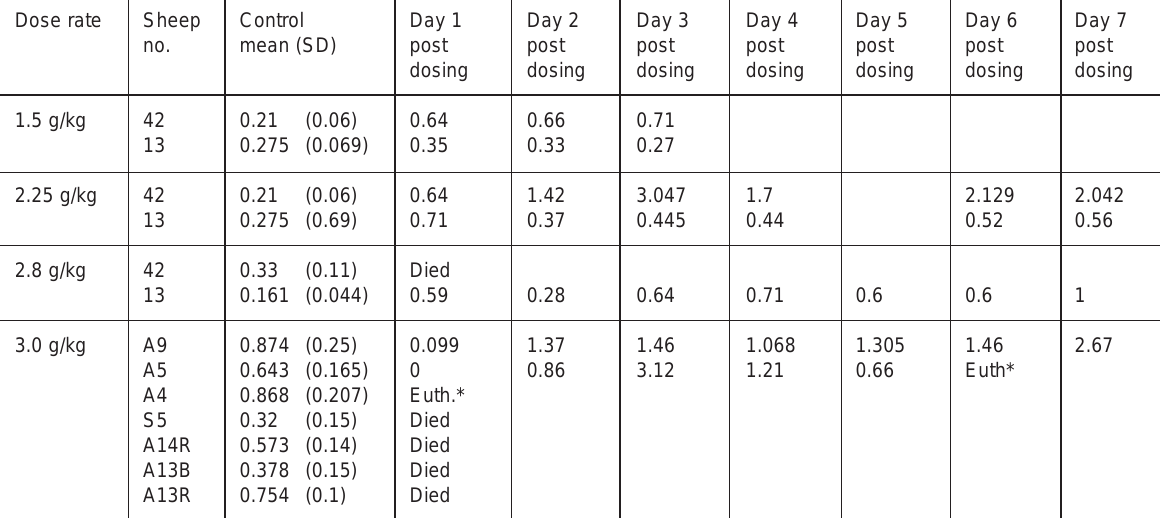
TABLE 2 Urine volumes ( l ) of sheep-control values and values following dosing with Nolletia gariepina Dose rate Sheep